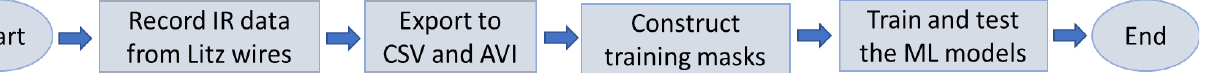
Figure 3. The flowchart depicts the process followed for recording and training models. The IR ra- diation from the wires was recorded during the heating and cooling cycles. The data obtained were used to construct training masks and train the machine learning models for enamel